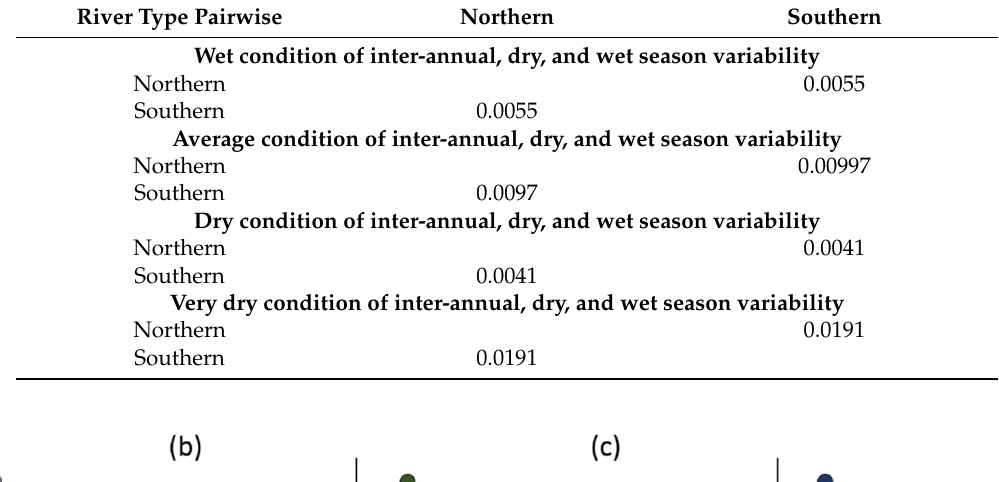
Table A4. Pairwise test of response variables between the groups per river type according to their location with regard to the Tropic of Cancer (one-way PERMANOVA). P -values with Bonferroni correction (Euclidean similarity index, permutation 9999 times).